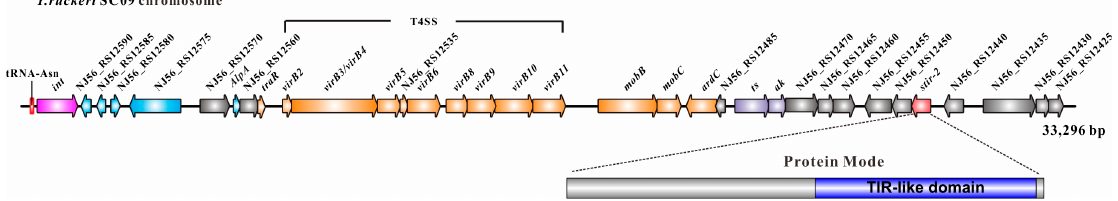
Figure 1. ICE(r2) with putative ICE regions in bacterial genomes. Operon structure of integrative and conjugative elements (ICEs). Int, integrase; T4SS, type 4 secretory system.